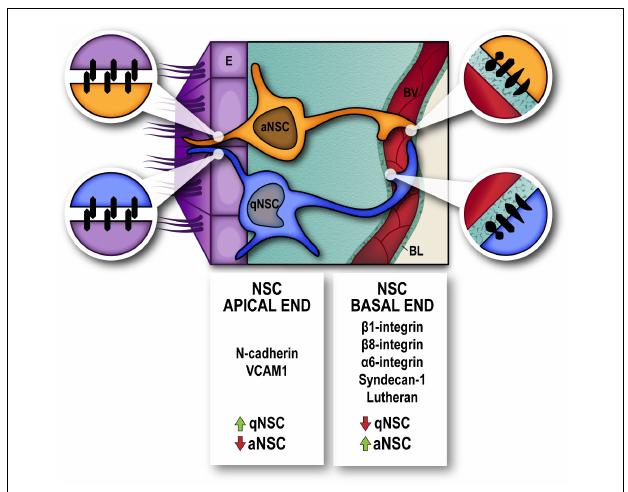
FIGURE 2 | Molecules involved in cell-cell adhesion and interaction with the niche extracellular matrix, actively participate in the regulation of neural stem cell dormancy/activation. Cell-cell junctions between Neural Stem Cells (NSC) and Ependyma (E) at the apical end (magnified circles, left) and Cell–Extracellular matrix interactions between NSC and endothelial basal lamina (BL) at the basal end (magnified circles, right), in the vicinity of blood vessels (BV), regulate the quiescence-activation state of NSC. High levels of N-cadherin and VCAM1 serve to maintain position and dormancy of quiescent neural stem cells (qNSC) within the niche by their apical end, whilst integrins α 6/ β 1 and β 8 and syndecan-1 and lutheran receptors are upregulated in neural stem cells that are actively proliferating